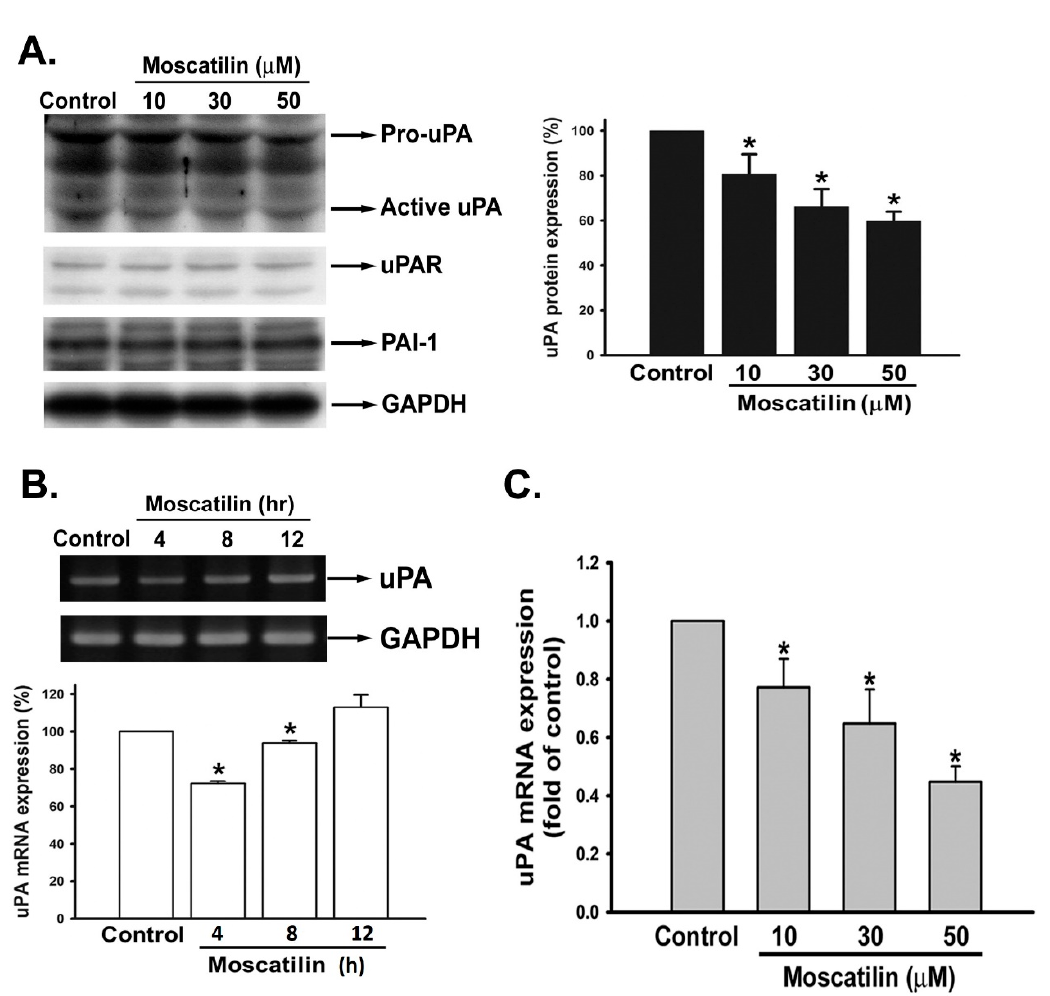
Figure 3. Effect of moscatilin on uPA mRNA and protein expression in human HCC cells. ( A ) SK-Hep-1 cells were treated with the indicated concentrations of moscatilin for 12 h in medium containing 10% FBS, and uPA, uPAR, and PAI-1 were determined by Western blot analysis. ( B ) SK-Hep-1 cells were treated with 30 μ M of moscatilin for 4, 8, and 12 h. Then, the mRNA level of uPA was detected by RT-PCR. Imaging was performed using quantitative densitometry with Image-Pro Plus. ( C ) The quantitative real time PCR was performed after 4 h of incubation with moscatilin (10, 30, 50 µ M) and normalized by GAPDH. Data are expressed as mean ± S.E.M. of four independent experiments. * p < 0.05 compared with the control group.